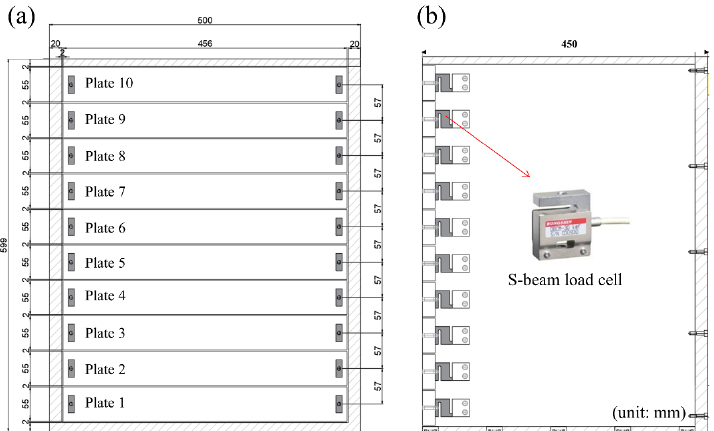
Figure 5. ( a ) Front view and ( b ) side view of the caisson model where the placement of the S-beam load cells is also illustrated. Table 1. Properties of the rubble stones used in the experiments.